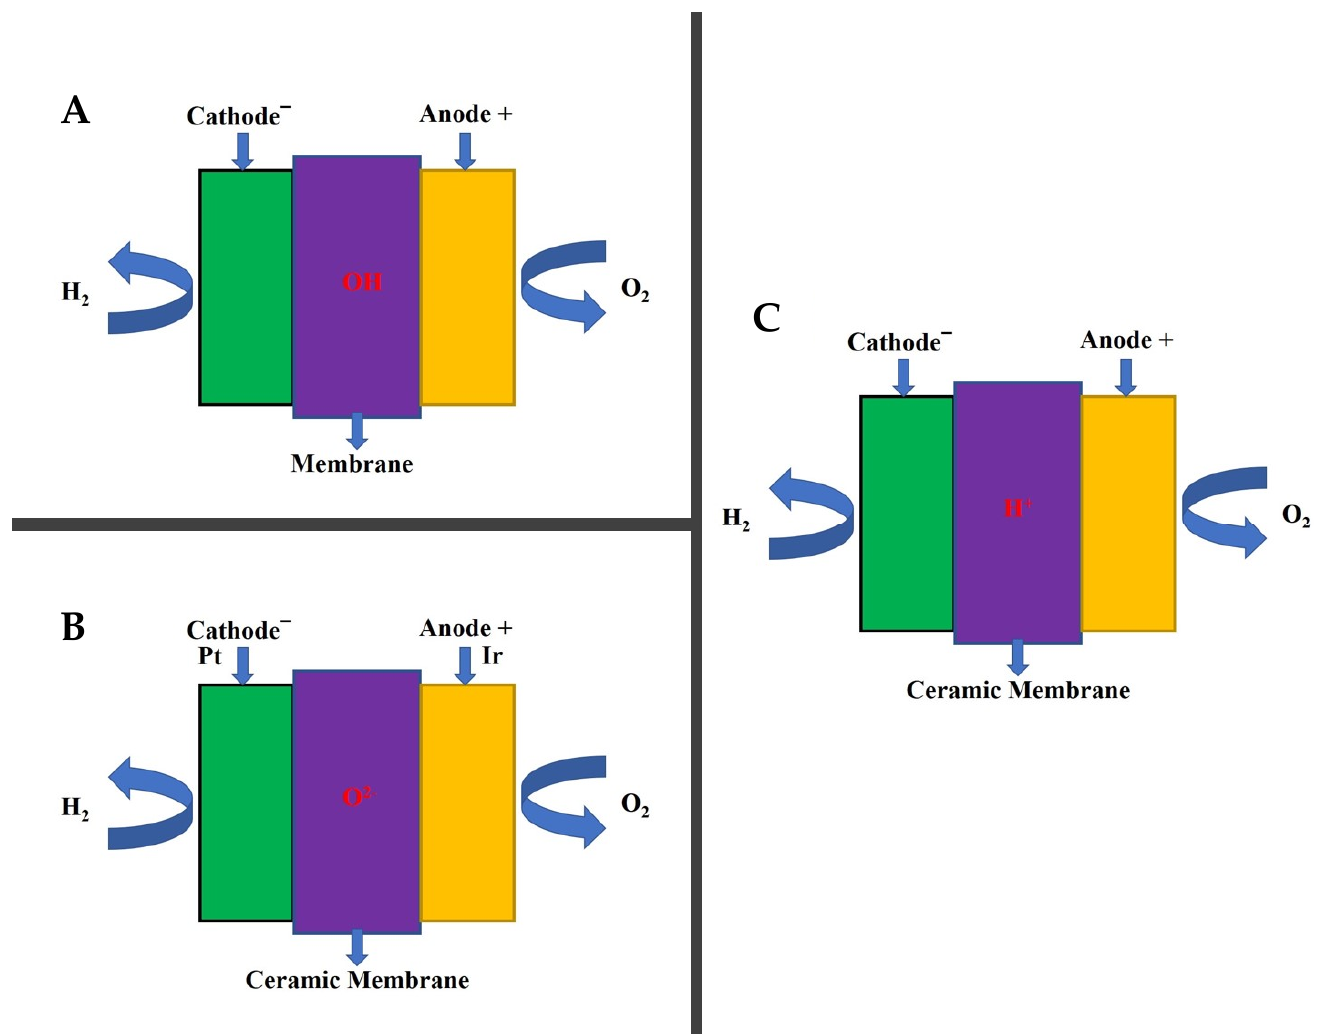
Figure 2. Schematic demonstration of ( A ) alkaline electrolysis, ( B ) solid oxide electrolysis, and ( C ) proton exchange membrane electrolysis. Reprint from [44]. Copyright (2021), with permission from Springer.